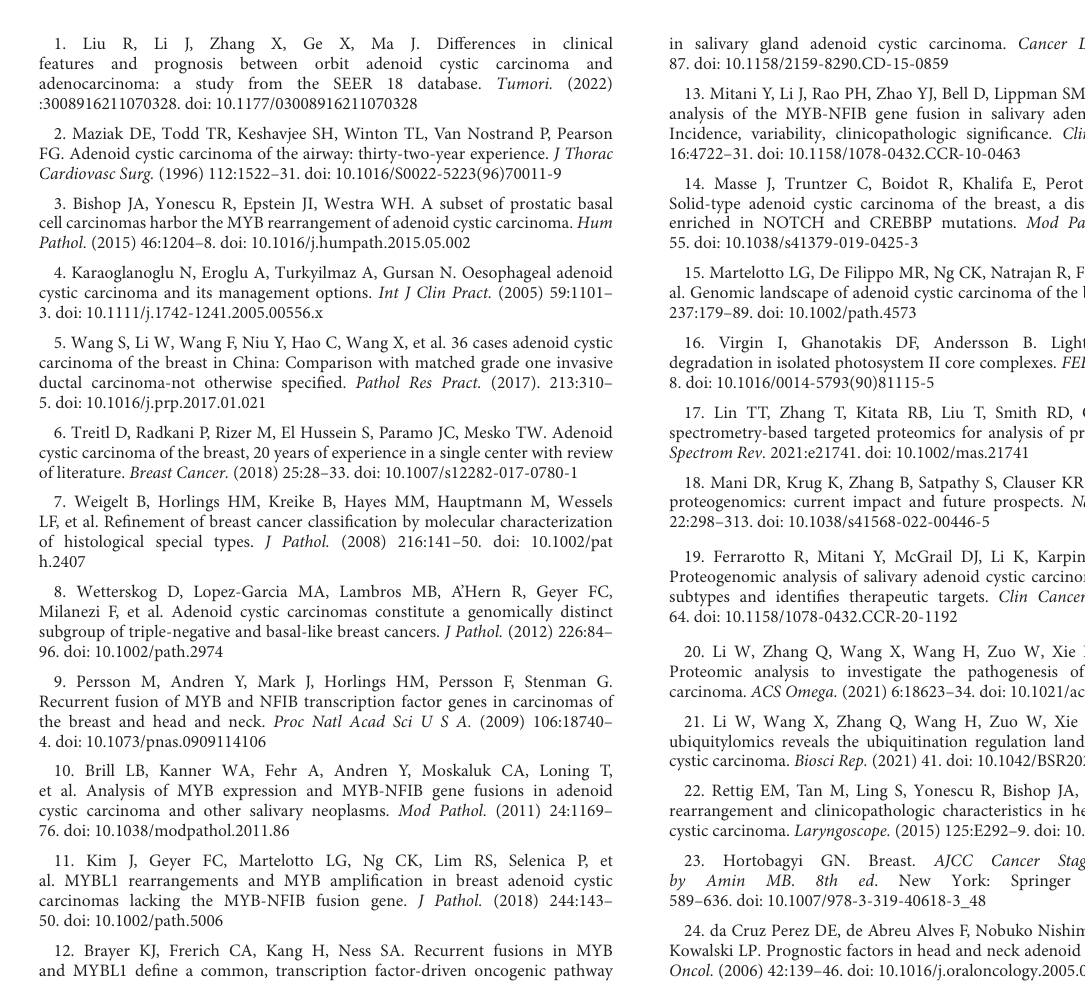
SUPPLEMENTARYFIGURE1 Quality control of protein data. (A) A heat map of proteins with missing values. (B) Normalization for all samples before and after normalization. (C) The PCA plot for a high-level overview of the data. SUPPLEMENTARYFIGURE2 (A) GSEA enriched GO analysis in ACC vs normal breast tissue. GO annotations indicating the top activated and suppressed GO terms based on biological process (BP). (B) GSEA enriched KEGG analysis in ACC vs normal breast tissue. The top activated and suppressed pathway is shown with the x-axis indicating gene ratio. p < 0.05 was considered significant. (C) PPI networks of upregulated biomarkers of adaptive immune response and RNA splicing using STRING v11.5. SUPPLEMENTARYTABLE1 All the quantified proteins and DEPs of ACC, BL-TNBC, and adjacent normal breast